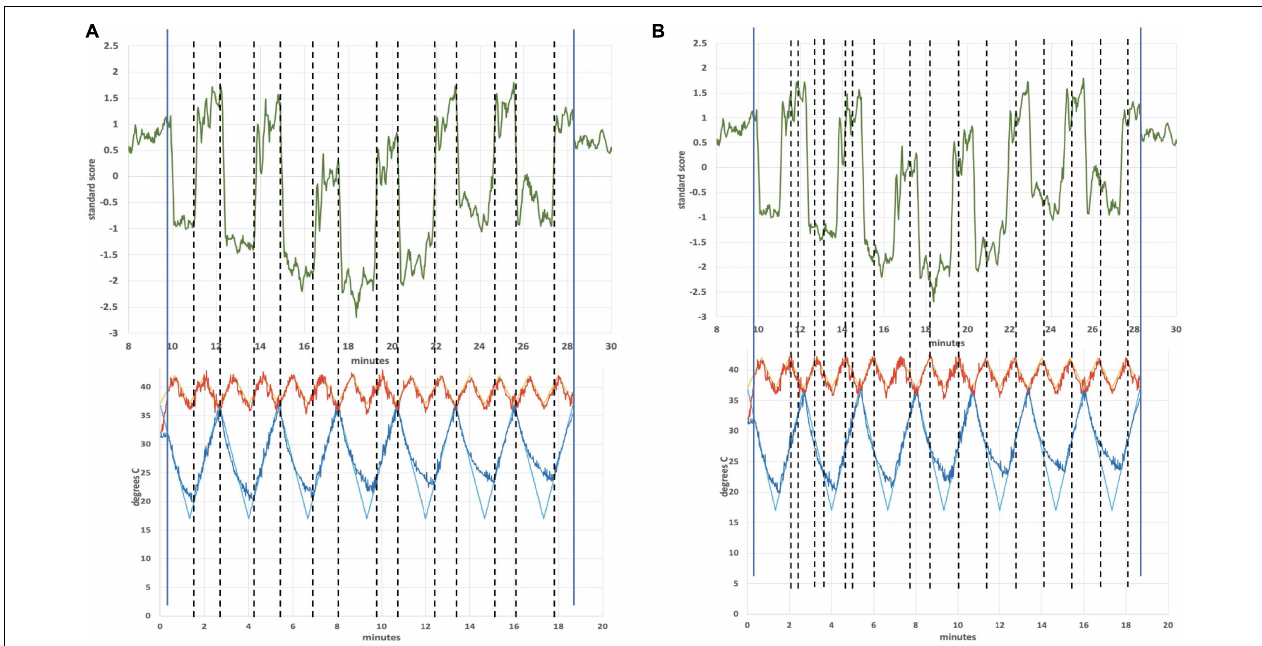
FIGURE 4 | (A) Cerebellar independent component, subject 4, overlaid with the thermal waveforms. The dotted lines are drawn to match features in the cold waveform to the ICA trace. For example, the two leftmost dotted lines are aligned with the first low point of the cold waveform and the subsequent high point. Those dotted lines align with the transitions between plateaus and troughs in the ICA trace; (B) Cerebellar independent component, subject 4, highlighting the warm waveform. The dotted lines match features in the warm waveform to the ICA trace, suggesting that the warm waveform may cause additional structure in the plateaus and troughs, even though the cold waveform creates the dominant effect on the ICA